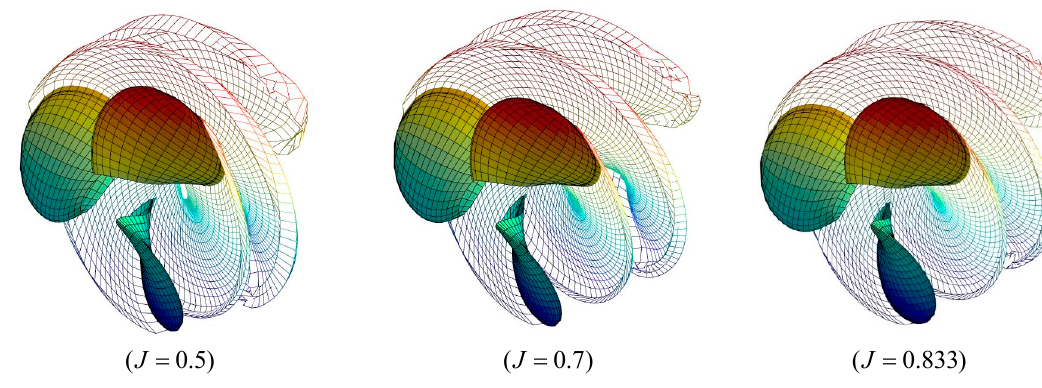
Figure 6. Wake surface of propeller for different advance ratios.